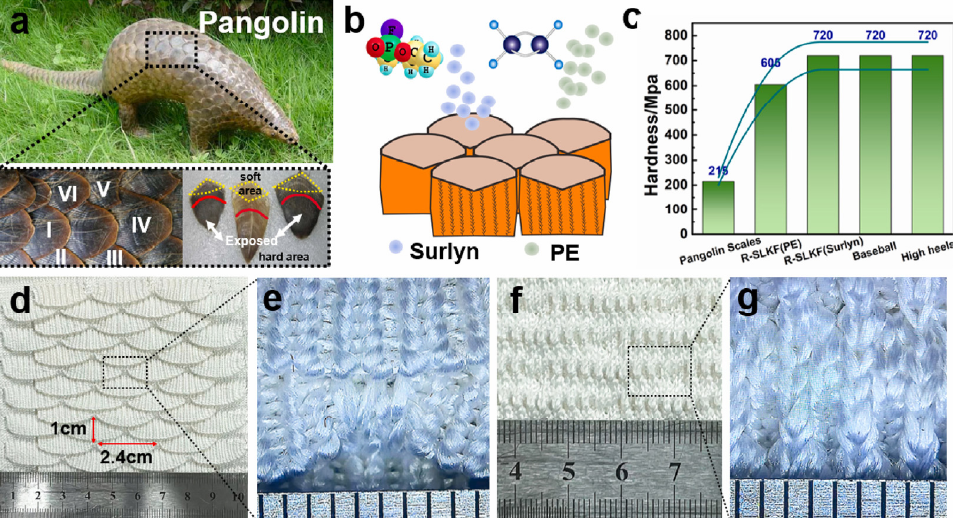
Figure 4. ( a ) Pangolin and its scales. ( b ) Preparation diagram of reinforced scale-like knitted fabric (R-SLKF). ( c ) Hardness of R-SLKF and comparison with other materials. ( d ) Optical image on the front of scale-like knitted fabric (SLKF) and ( e ) enlarged view. ( f ) Optical image on the back of SLKF and ( g ) enlarged view. Reprinted from [38], Copyright (2022), with permission from Elsevier.